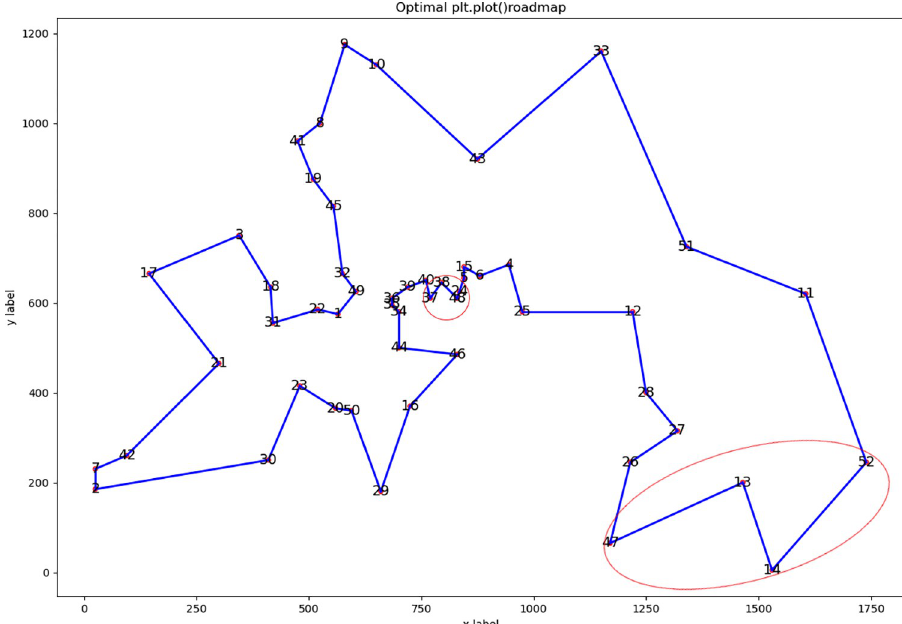
Fig 5. The optimal route of Berlin52 output by DSRABSQL algorithm.